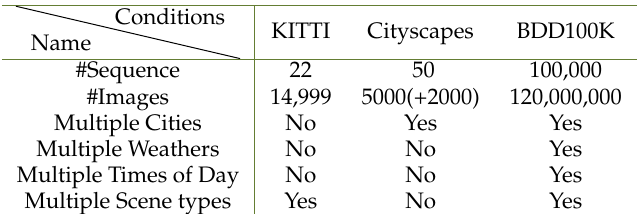
Table 1. Comparison of different datasets